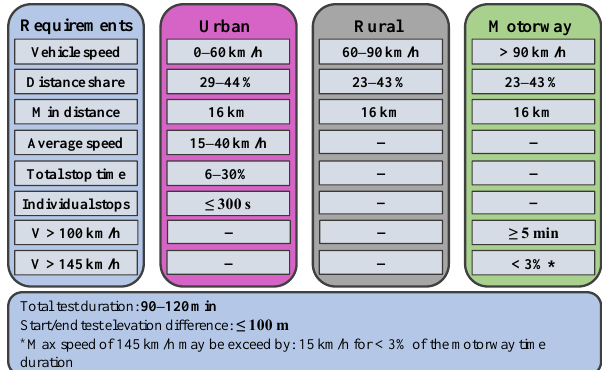
Fig. 1. The RDE test requirements